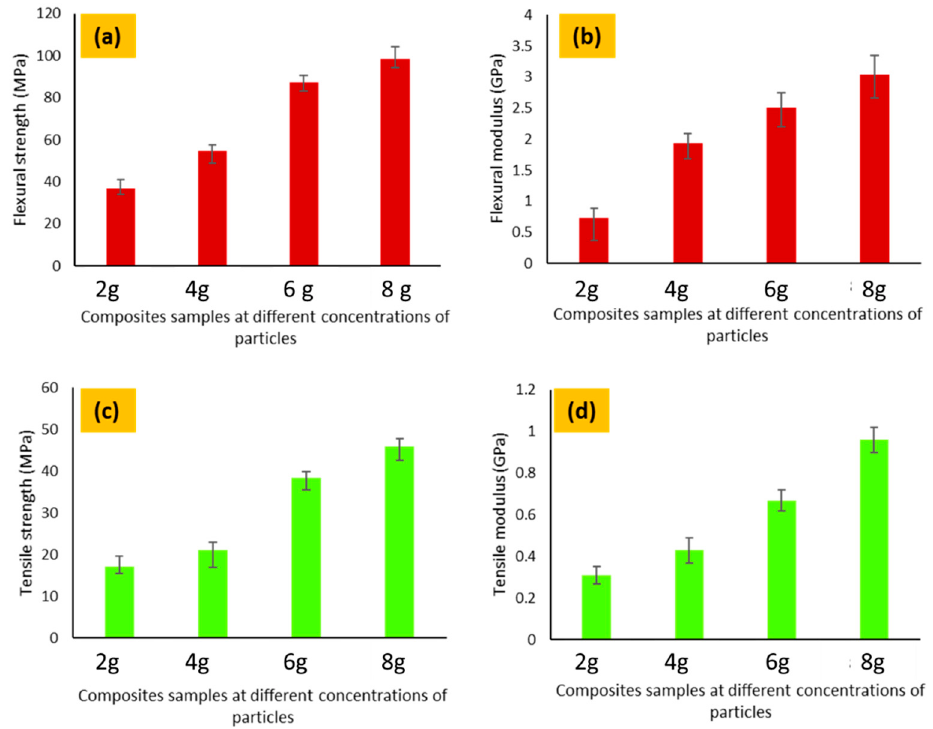
Figure 18. Mechanical properties of conductive composites ( a ) Tensile strength ( b ) Tensile modulus ( c ) Flexural strength and ( d ) Flexural modulus.